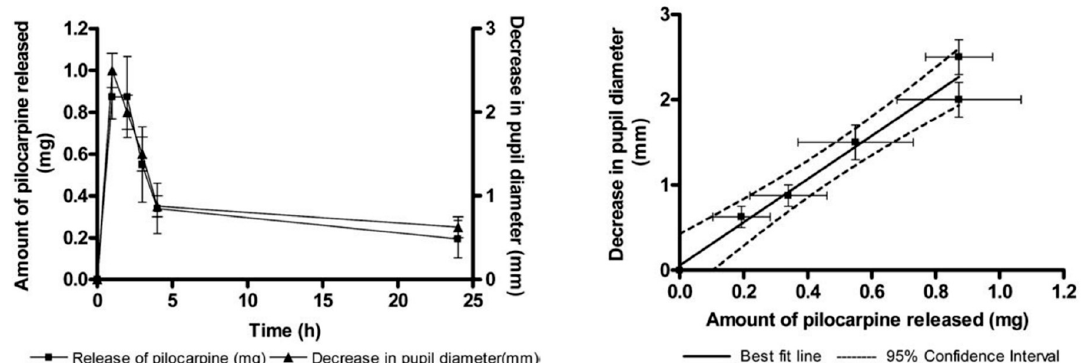
Figure 6. Correlation between in vitro pilocarpine release and pupillary constriction obtained in vivo. A linear correlation is evident with an R 2 of 0.97. As the amount of pilocarpine available for absorption decreases, a corresponding increase in pupil diameter is observed. Data are reported as mean ± SEM. Solid line indicates the best-fit line and dashed line indicates the 95% confidence interval. (Reprinted with permission from reference [1]. Copyright 2009